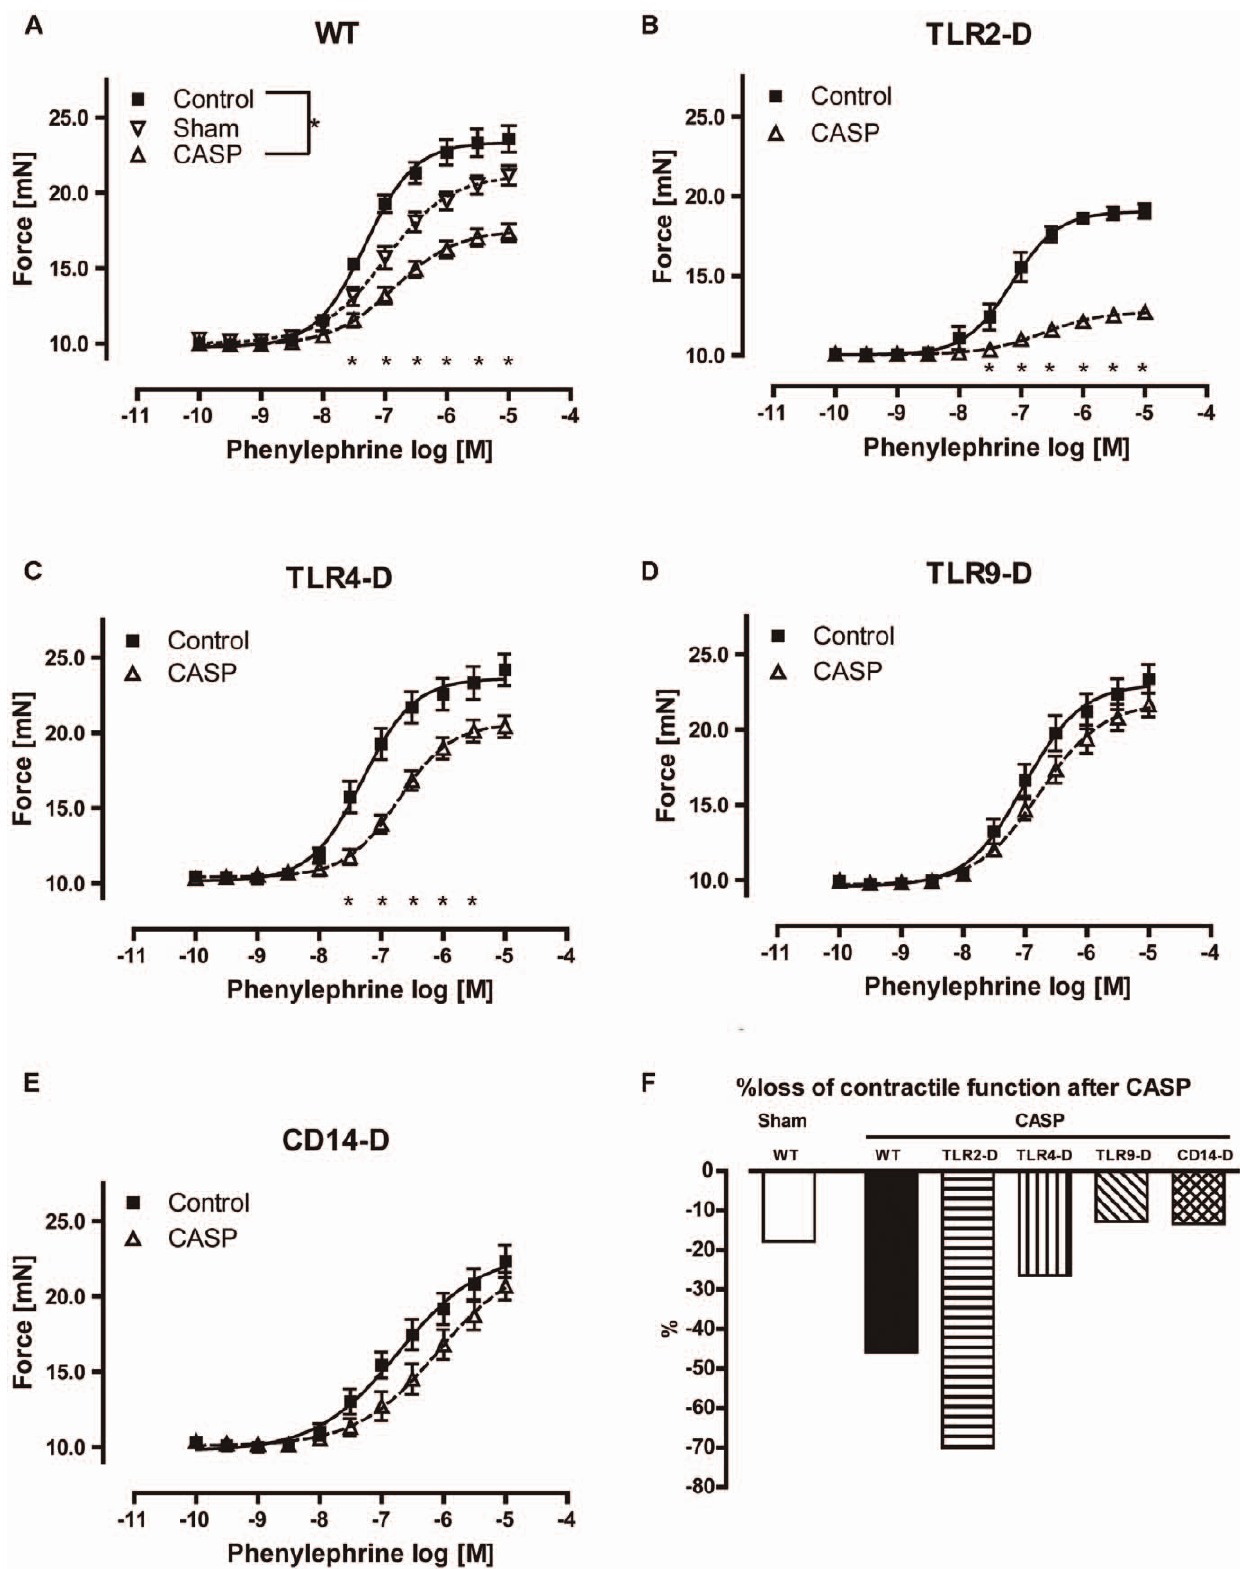
Figure 3. Arterial contractility 18 hours after CASP. A A significant hypocontractility of aortic rings in CASP- WT animals, but not in sham- operated WT animals was observed at phenylephrine concentrations of 10 2 7,5 to 10 2 5 M. B TLR2-D mice exhibited a significantly lower maximal contractile response compared to WT animals (TLR2-D 19.07 6 0.454 mN vs. WT 23.59 6 0.872 mN; p , 0.05). C Significant reduction of vascular contractility following CASP was also observed in TLR4-D mice compared to controls (p , 0.05), but it was less severe than in WT animals. D, E CASP